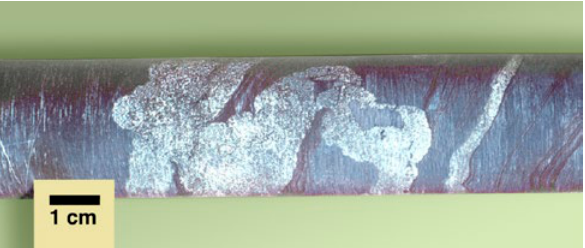
Figure 76. A ptygmatic-type clastic mud dyke or "dirty early quartz vein" has been intruded into soft diagenetic banded hematite shales. These early "out-wellings" of entrapped fluid through fine oozy sed- iment are episodic with each successive reactivation becoming more quartz rich until the filling material resembles vein quartz. Explorer 8 drill core, Tennant